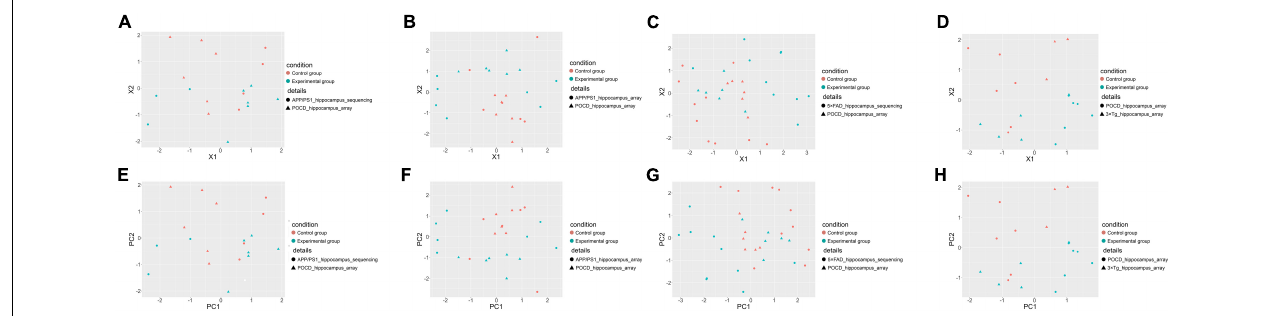
FIGURE 3 | Overall pathway-level comparison of the hippocampal transcriptomic changes between POCD and different AD transgenic models visualized through principal coordinate analysis (A–D) and principal component analysis (E–H) . (A) GSE95426 (POCD model microarray data) vs. GSE93678 (APP/PS1 model RNA-seq data); (B) GSE95426 vs. GSE135999 (APP/PS1 model microarray data); (C) GSE95426 vs. GSE168137 (5 × FAD model RNA-seq data); (D) GSE95426 vs. GSE165111 (3 × Tg model microarray data). (E) GSE95426 (POCD model microarray data) vs. GSE93678 (APP/PS1 model RNA-seq data); (F) GSE95426 vs. GSE135999 (APP/PS1 model microarray data); (G) GSE95426 vs. GSE168137 (5 × FAD model RNA-seq data); (H) GSE95426 vs. GSE165111 (3 × Tg model microarray